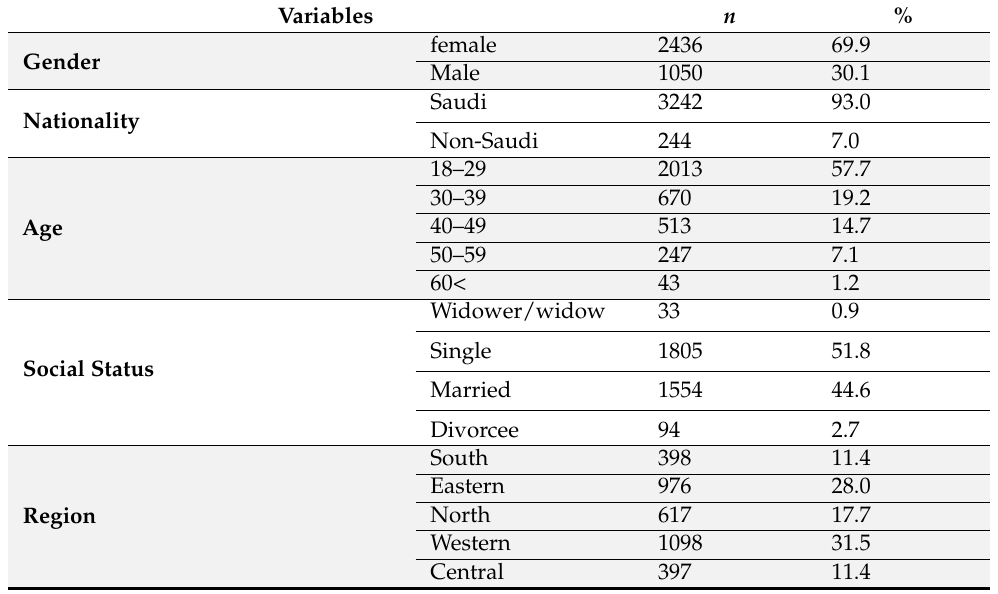
Table 1. Baseline characteristics of participants ( n =